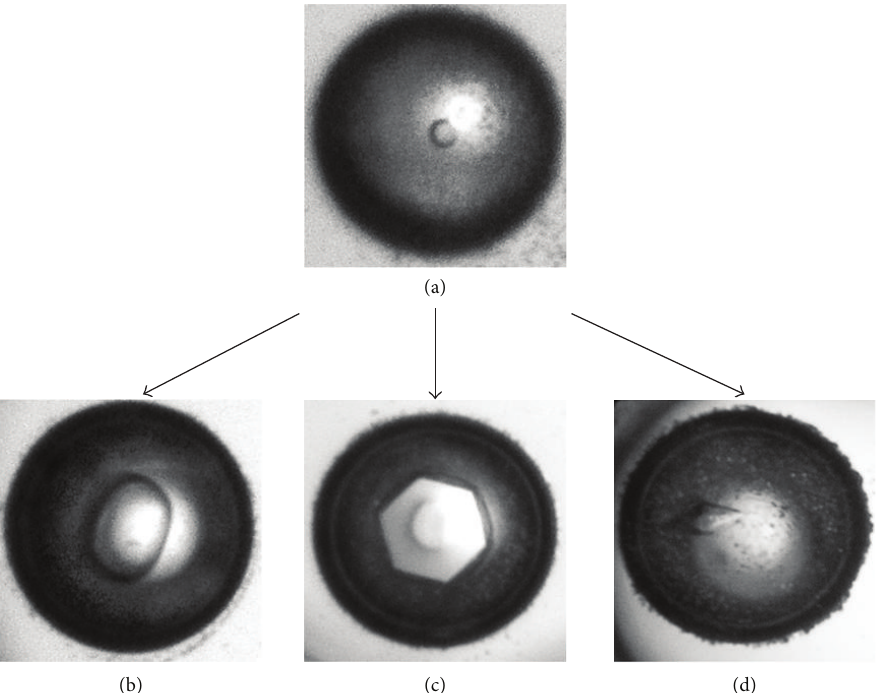
Figure6:Commonicecrystalmorphologychangesbasedantifreezeactivitypresent.(a)Priortoicecrystalshaping,icecrystalsareaspherical shape. (b) When there is a lack of ice crystal shaping, the crystal grows and remains circular (control buffer only). (c) Low level of antifreeze activity is represented by a hexagonal ice crystals. (d) Ice crystals seen with moderate level of antifreeze activity are usually observed as hexagonal